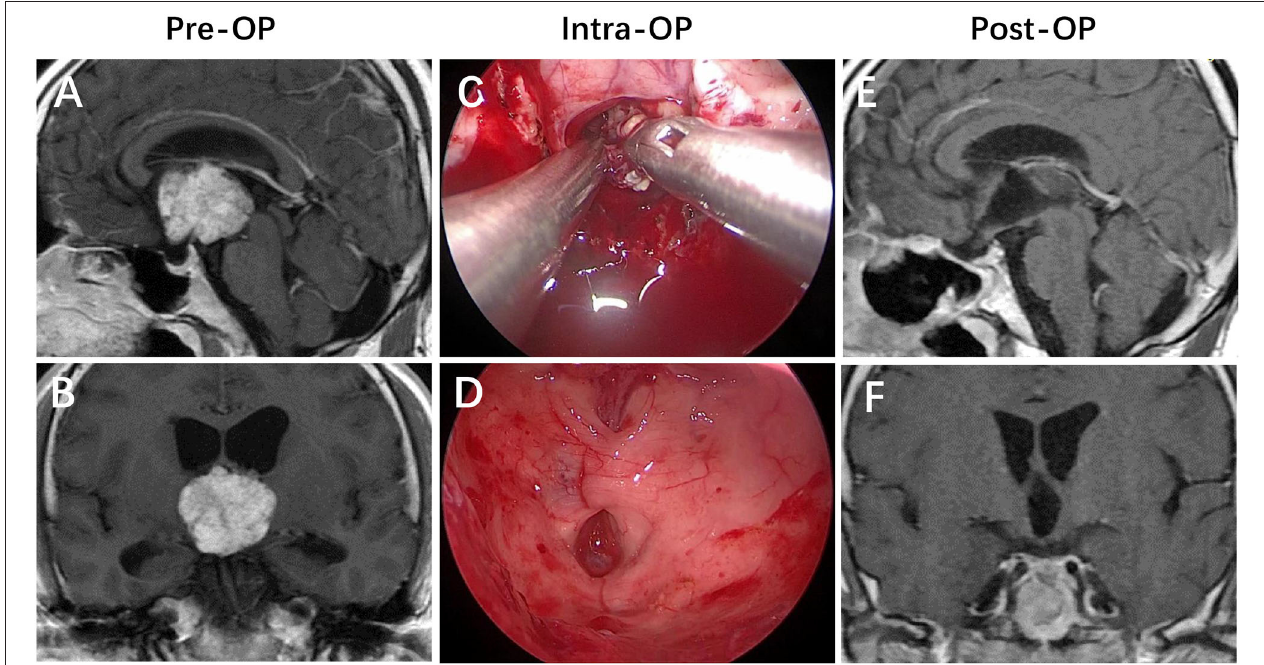
FIGURE 1 | Strictly intraventricular craniopharyngioma. (A,B) Preoperative enhanced MRI demonstrated a mass that is localized in the third ventricle cavity with an intact floor lying below its inferior surface. (C,D) Intraoperative findings revealed that the patient achieved a gross-total resection of the lesion via the endoscopic endonasal suprachiasmatic trans-lamina terminalis corridor. (E,F) Postoperative enhanced MRI revealed that the lesion was totally removed, with the posterior wall of the third ventricle preserved intactly.